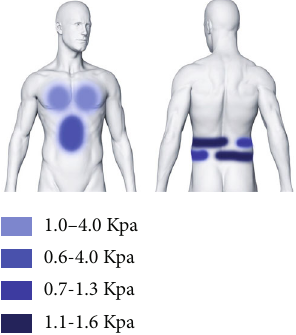
Figure 4: Distribution of body contact pressure in the face-to-face hugging at the